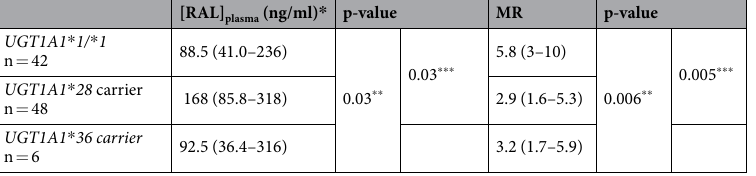
Table 3. RAL plasmatic concentrations [RAL] plasma and [RAL-glu] plasma /[RAL] plasma ratio depending on UGT1A1 allelic status. * Concentrations are expressed as median with interquartile range (IQR). **